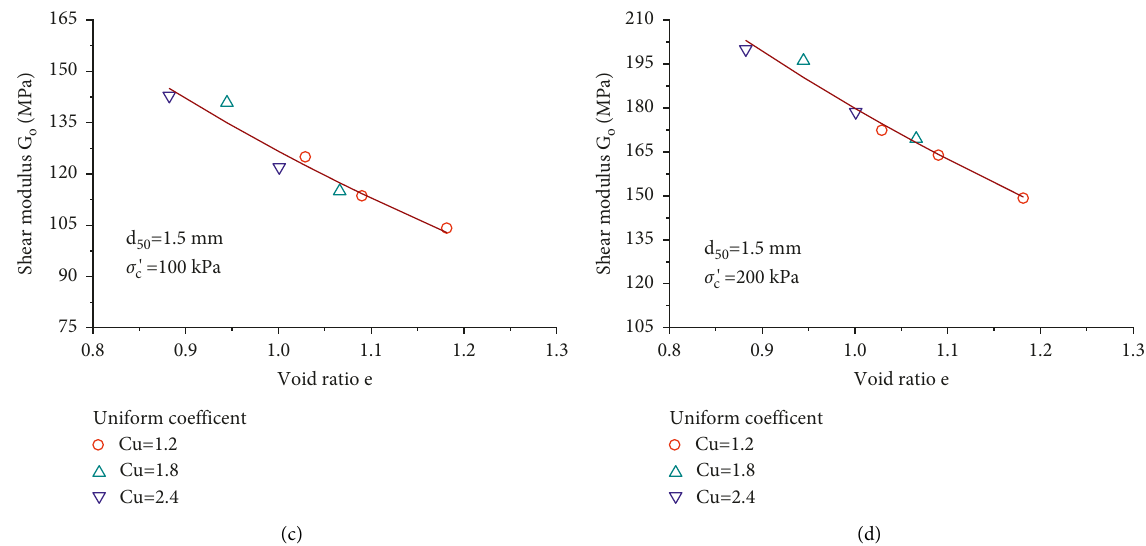
Figure 8: Shear modulus and void ratio for calcareous sand with varying uniform coefficient Cu. (a) d